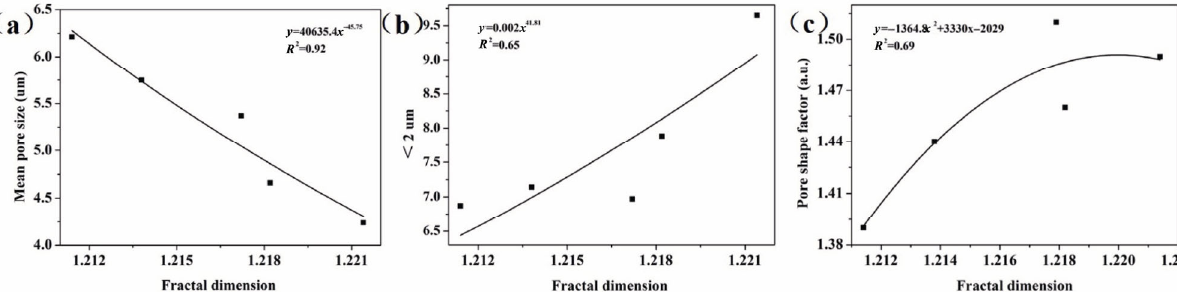
Fig. 9 Relationship between fractal dimension and pore structure: (a) mean pore size, (b) proportion of micro-pore < 2 µm, and (c) pore shape